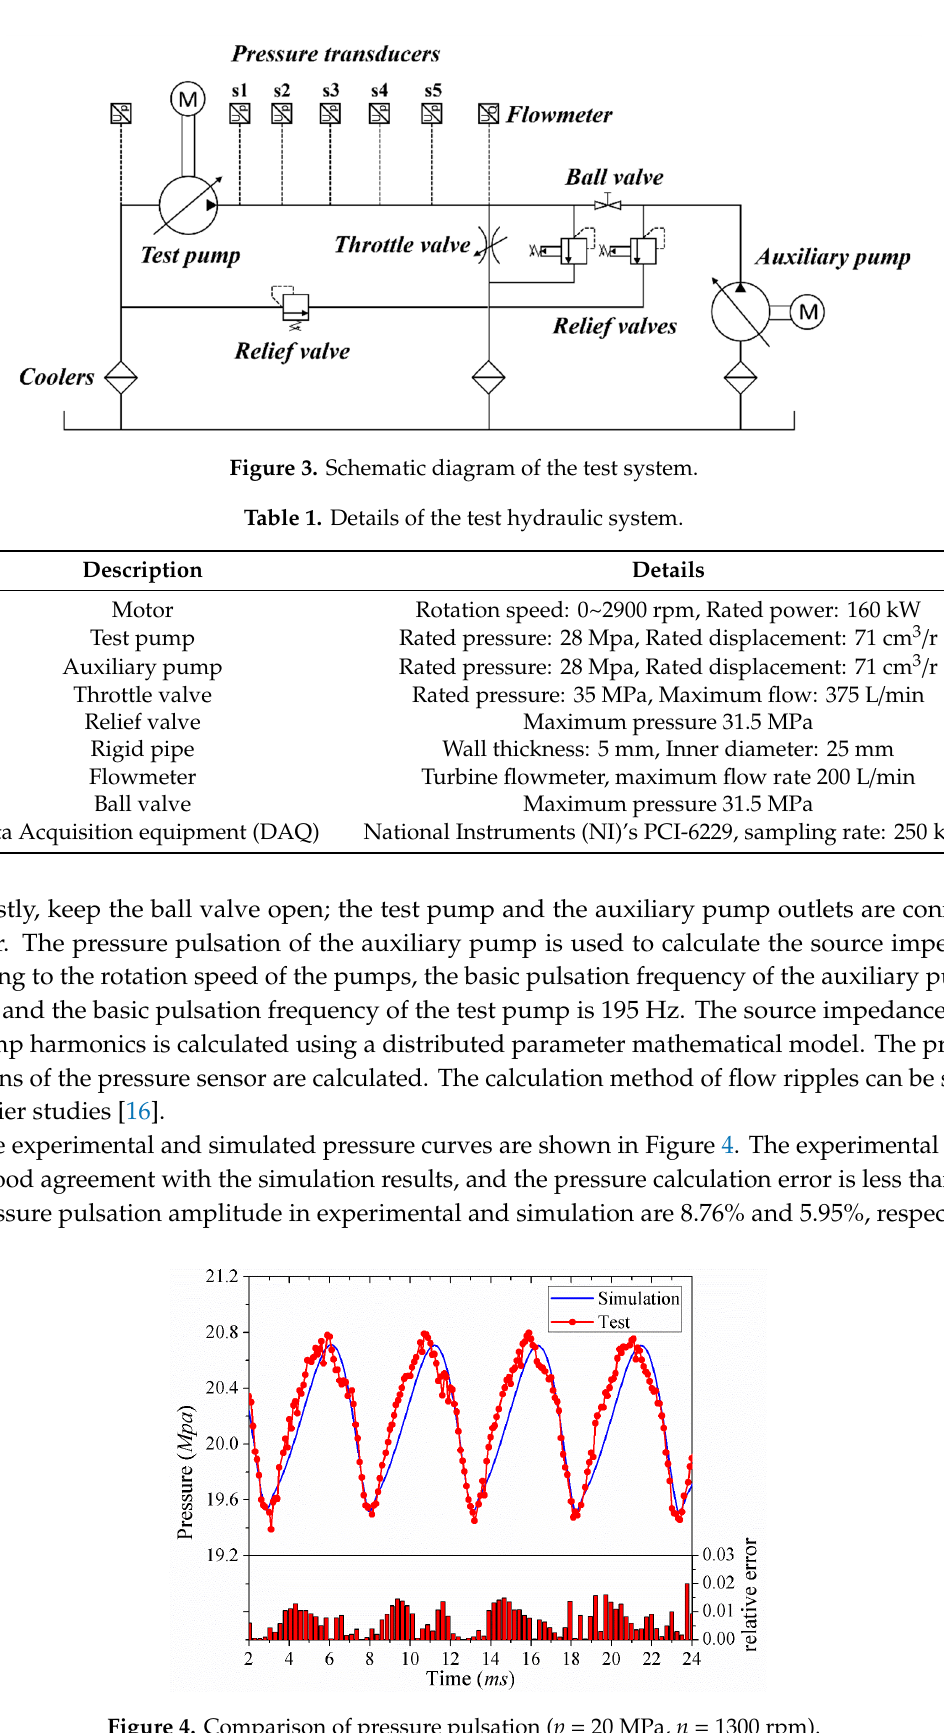
Figure 4. Comparison of pressure pulsation ( p = 20 MPa, n = 1300 rpm).